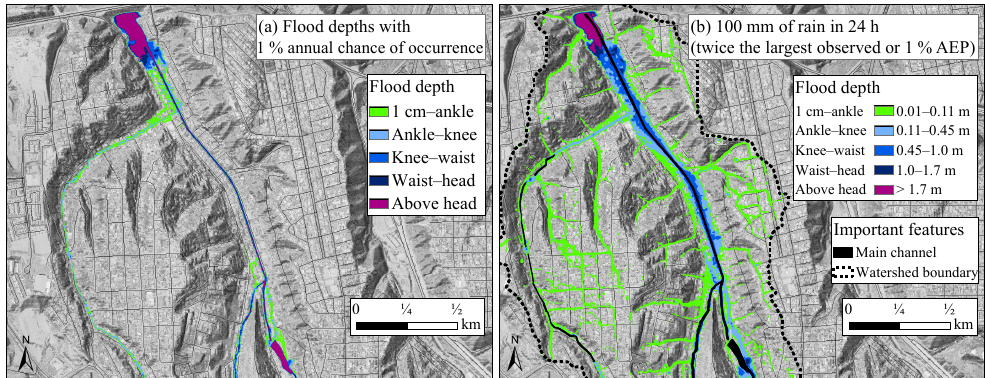
Figure 7. (a) Pre-focus group Los Laureles flood depth map based on traditional coupling of hydrologic and hydraulic models. (b) Post- focus group Los Laureles flood depth map based on routing storm-water runoff using the hydraulic model grid. Comparison between (a) and (b) shows that traditional hydrologic–hydraulic model coupling can misrepresent flood hazards in catchments where storm-water runoff is severe. We also present (b) following the stakeholder requests. Notice that (a) is described by the AEP of the flood depths, whereas (b) is described by the amount of rainfall that caused the mapped hazard. The post-focus group map also includes a qualitative/quantitative legend, the location of the main channel, and the watershed